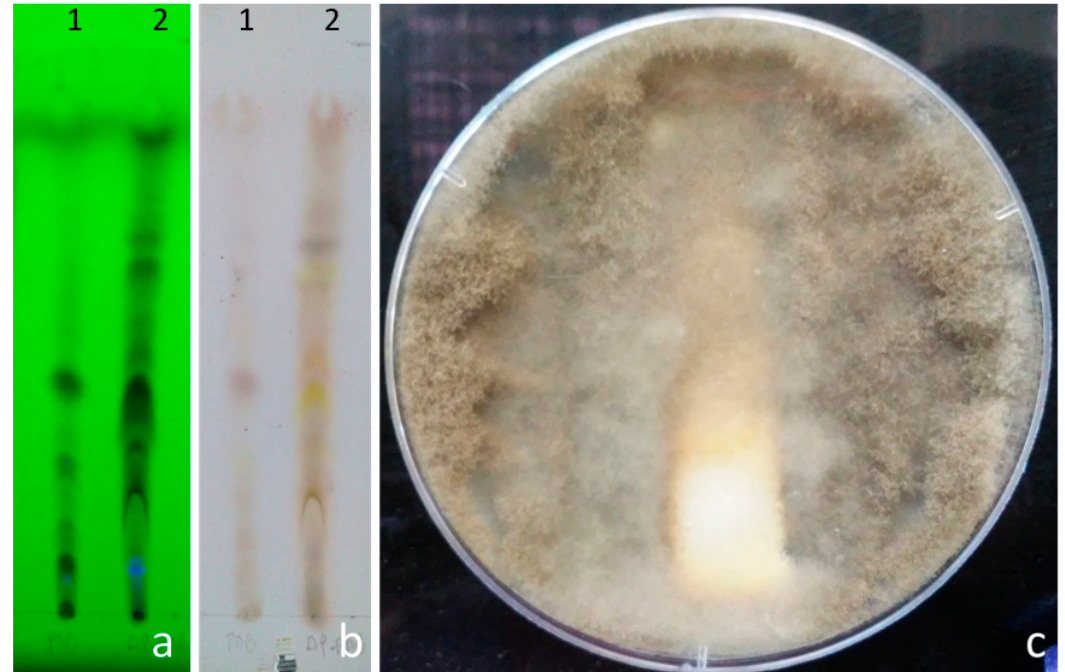
Figure 3. Compounds extracted from Ec1 isolate and their antifungal activity on B. cinerea . ( a ) Chromatogram of the extract visualized under UV light at 254 nm. ( b ) Chromatogram of the extract revealed with 25% H 2 SO 4. Lane 1, compounds obtained from the culture medium in the absence of isolate Ec1. Lane 2, compounds secreted by the isolate Ec1. Mobile phase CHCl 3 /MeOH 95: 5. ( c ) Bioautography of the extract obtained from Ec1 after 7 days of B. cinerea incubation at 22 °C.